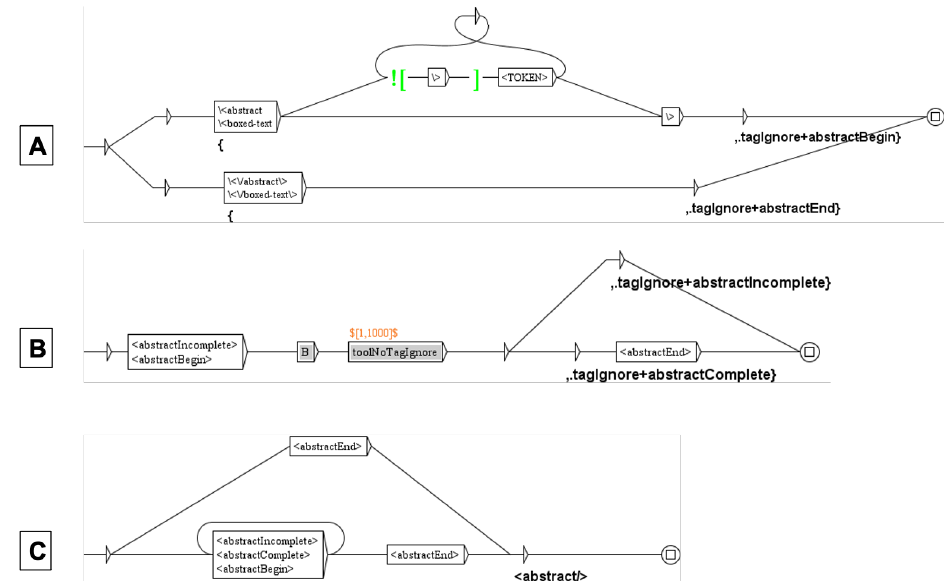
Figure 5. Graph ( A ) marks the beginning and the end of the abstract, recursive graph ( B ) transforms 1000 tokens of the text of the abstract in only one and graph ( C ) replaces the abstract by < abstract / >